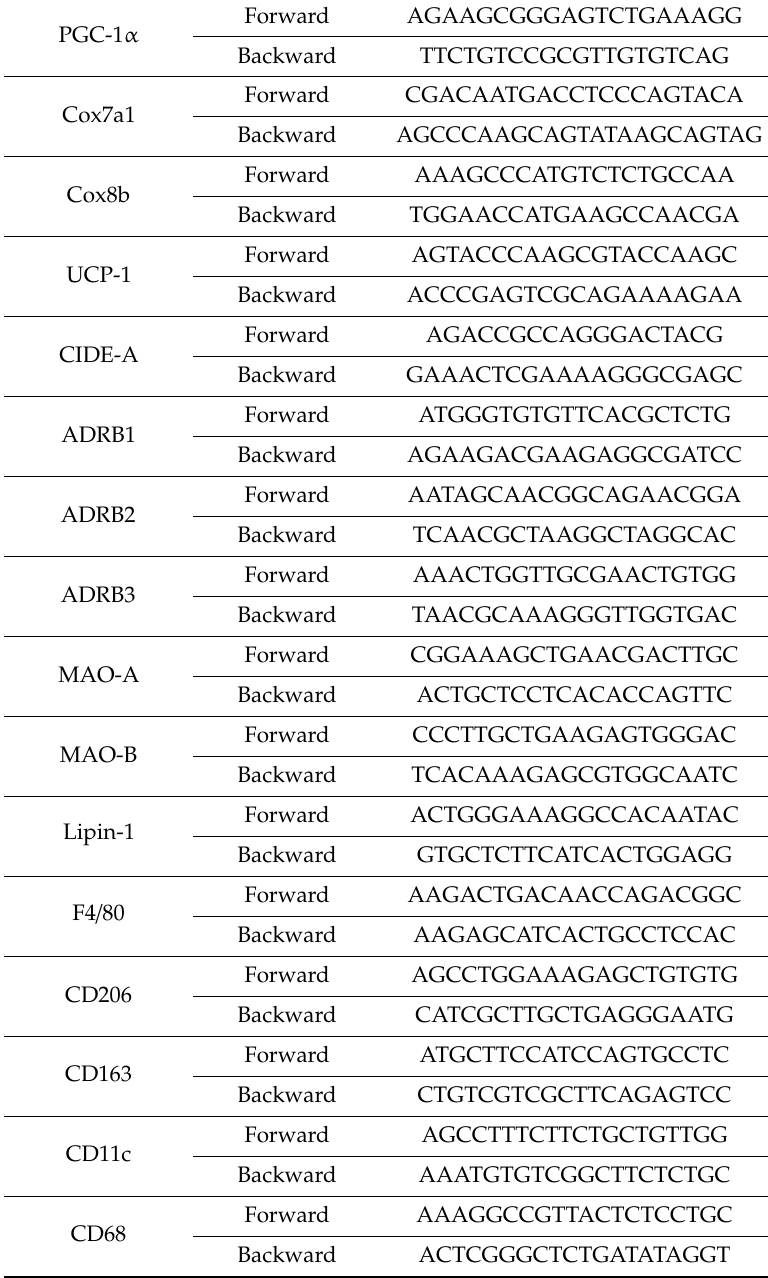
Table 1. Primer sequences used in the